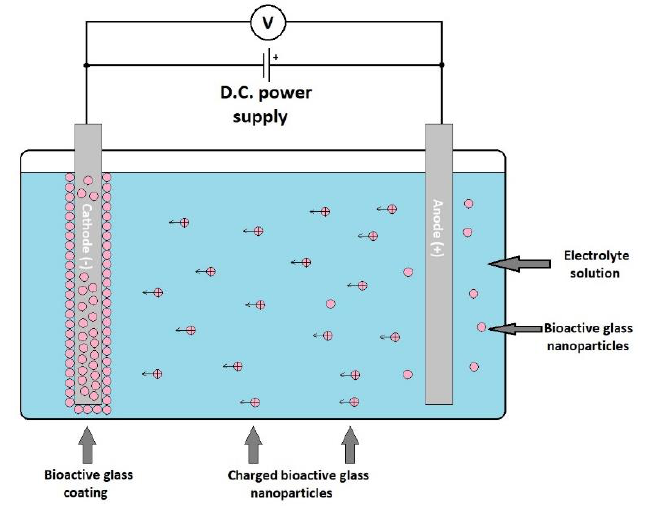
Figure 7. Schematic representation of an electrophoretic deposition process.